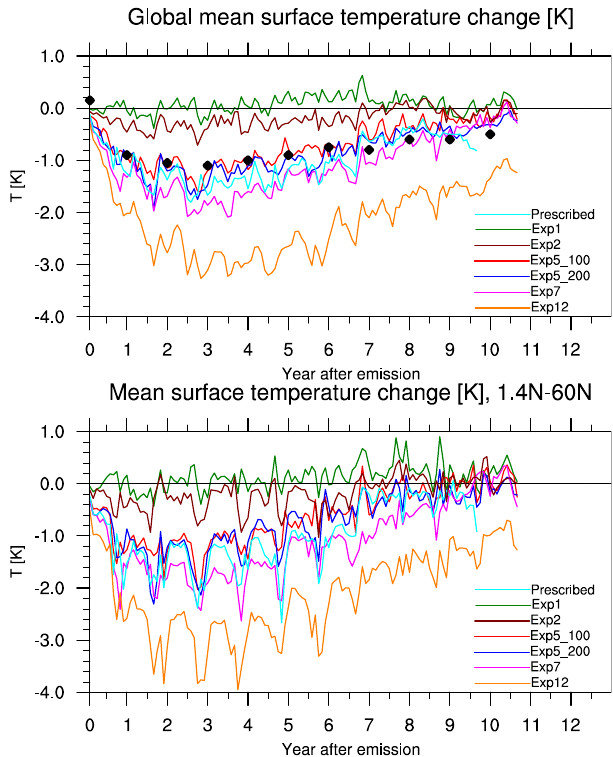
Fig. 5. Mean surface temperature changes [ K ] as function of time, globally averaged (upper panel) and averaged between 1.4 ◦ N and 60 ◦ N (lower panel). The black diamonds in the upper panel indicate the global mean temperature changes in May of each year for the 5Tg case by Robock et al. (2007b, their Fig.